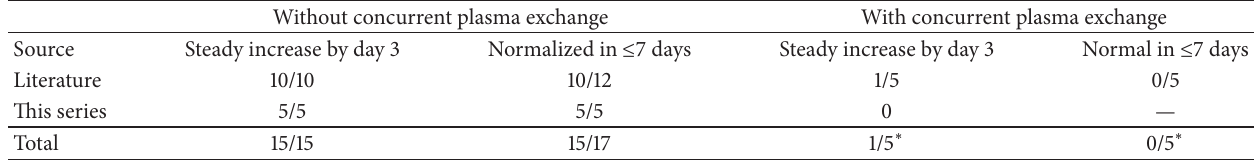
Numerator indicates the number of cases with response; denominator is the number of cases with available data. ∗ 𝑃 = 0.001 and 0.0008, respectively, versus its counter group without plasma exchange (Fisher’s exact